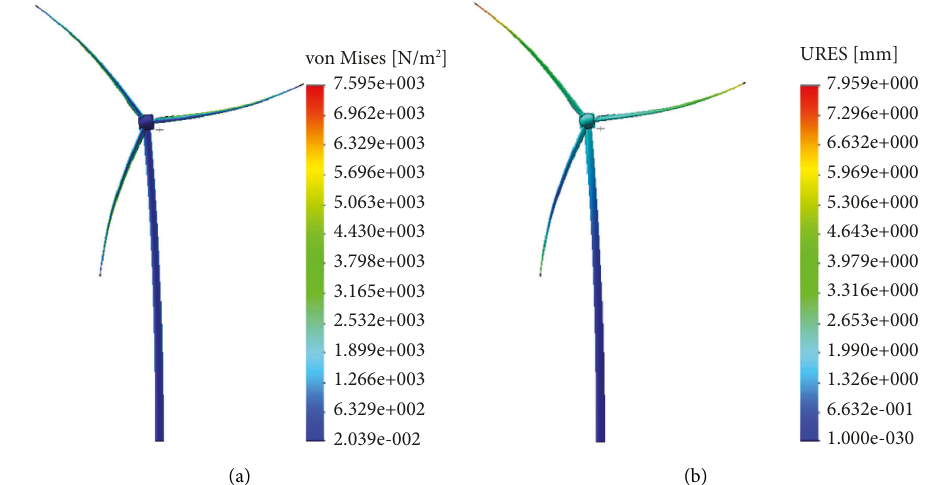
Figure 9: . Dynamic response of 5784N. (a) Stress and (b) combined displacement.